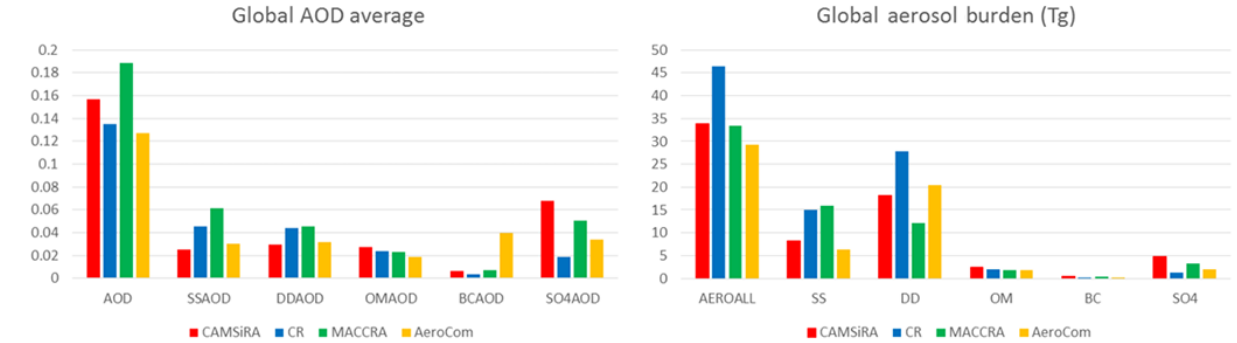
Figure 7. Global average of total AOD (550nm) and species AOD (left), global total and species, and burden in teragrams (right) of sea salt (SS), desert dust (DD), organic matter (OM), black carbon (BC), and sulfate aerosol (SO 4 ) for CAMSiRA (red), the CR (blue), and MACCRA (green) and the median of the AeroCom model intercomparison (yellow, Kinne et al., 2006; Textor et al., 2006).